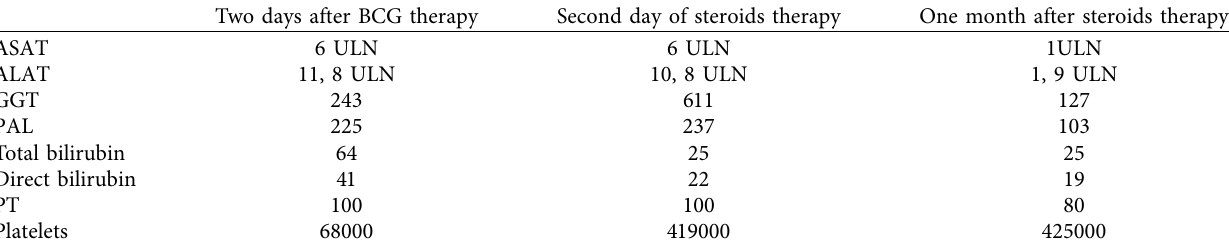
Figure 1: Histological results of the liver biopsy puncture of our patient (laboratory of pathological anatomy, CHU Hassan II of Fez). (a) Epitheloid granuloma without giant cells and without caseous necrosis (HPS ∗ 200). (b) Anti-CD68 antibody highlighted epi- theloid granulomas on immunohistochemistry. (c) Anti-CK19 antibody showed portal cholangiolar proliferation on immunohistochemistry. Table 1: Results and evolution of our patient’s